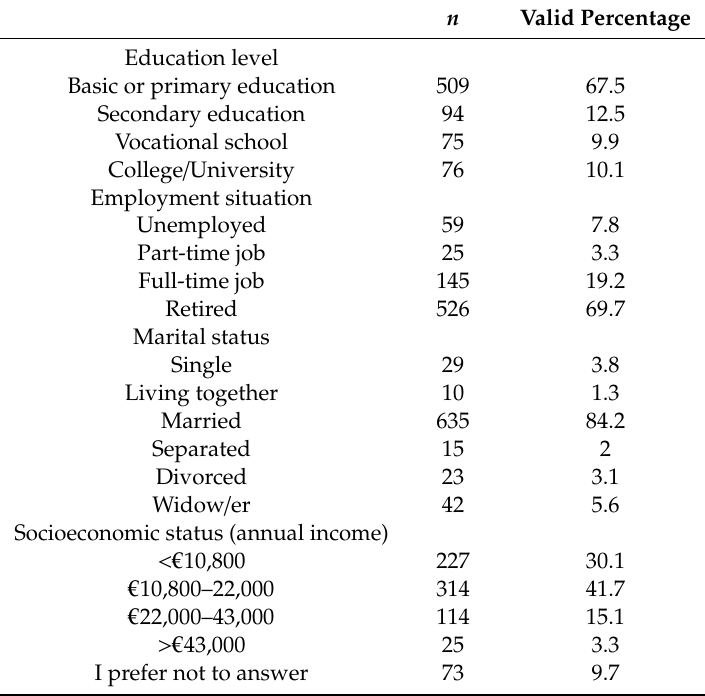
Table 1. Sociodemographic characteristics of the